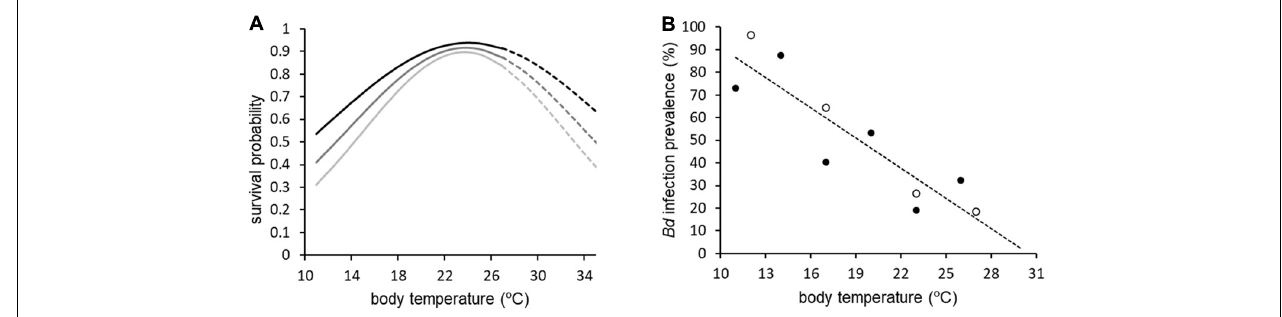
FIGURE 1 | Probability of survival (A) and Bd infection prevalence (B) for Bd -infected A. crepitans as a function of temperature, based on laboratory exposure studies. In (A) , predictions are shown for 20, 30, and 40 days after infection and solid lines are within the range of temperatures included in Sonn et al. (2017) whereas dashed lines represent extrapolated relationships. In (B) , open circles are median daily temperatures from Sonn et al. (2019) whereas closed circles are constant temperature treatments from Sonn et al. (2017). The equation for polynomial describing survival probability ( S ) as a function of body temperature ( x , in ◦ C) and time ( t , in days post exposure) in (A) is S ( t, x ) = (0.0046 x + 0.874)eˆ(-0.000163 x 2 + 0.00762 x – 0.091346) t . The equation for the line of best fit describing infection prevalence ( y ) in (B) is y = -4.4407 x + 135.42, with R 2 =